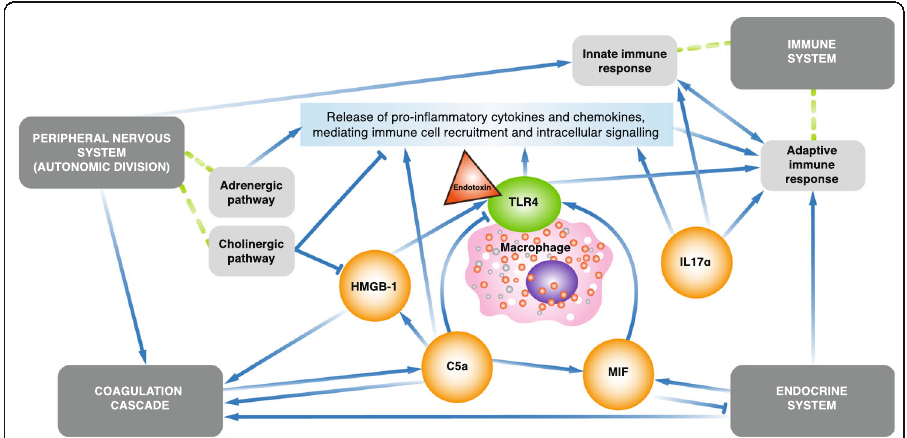
Fig. 1 Centers of activity in the inflammatory network driving sepsis. Abbreviations : C5a complement 5a, HMGB-1 high-mobility group box 1 protein, IL-17A interleukin-17A, MIF macrophage migration inhibitory factor, TLR4 Toll-like receptor 4